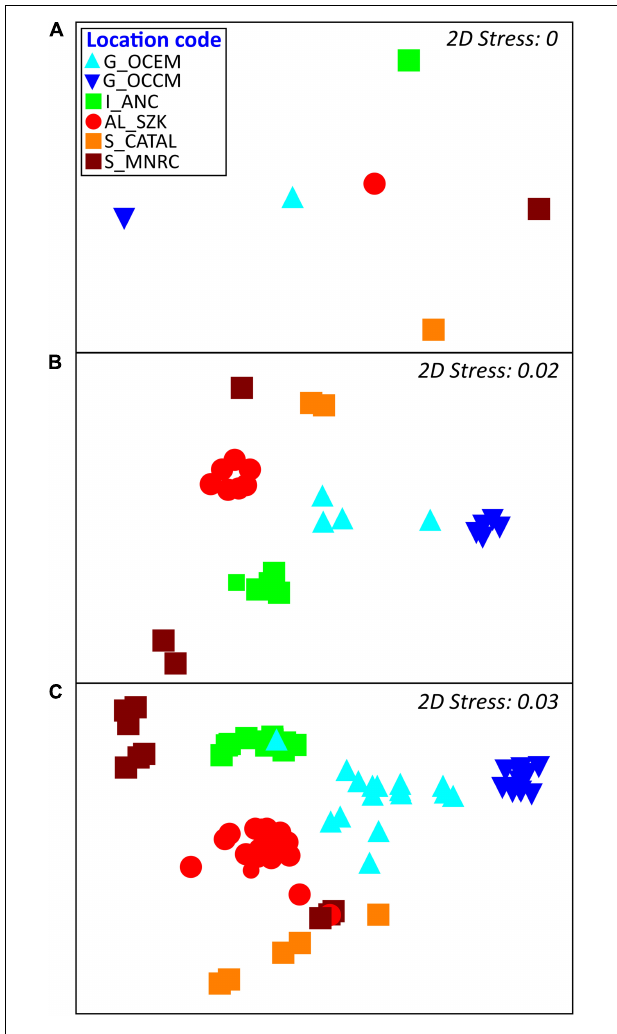
FIGURE 4 | Non-metric multidimensional scaling (nMDS) analysis plot based on Bray-Curtis Index values showing the spatial similarities across locations (A) , forests (B) , and transects (C) . For further information for the location codes see Figure 1 . For the forest and transect codes see Supplementary